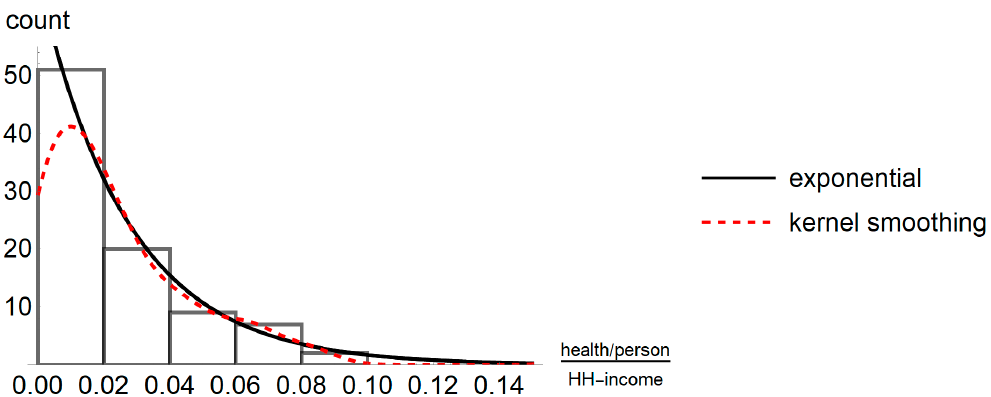
Figure 5. Histogram of health-related HH-expenditures of slum-dwellers in relation to HH-income (91 data, exceptionally large fractions were not plotted in the histogram, but considered for the computations) and probability density functions: exponential distribution (black) with m = 2.7% (one-sided 95% confidence limits: 2.3–3.2%) and smooth-kernel distribution (dashed red. The Cramér-von Mises distribution fit test confirmed the good fit ( p -value 29.6% using a simulation). To obtain comparable scales, functions were multiplied with 1.82 (91 data times 0.02 bin width); computations: Mathematica 11.3.